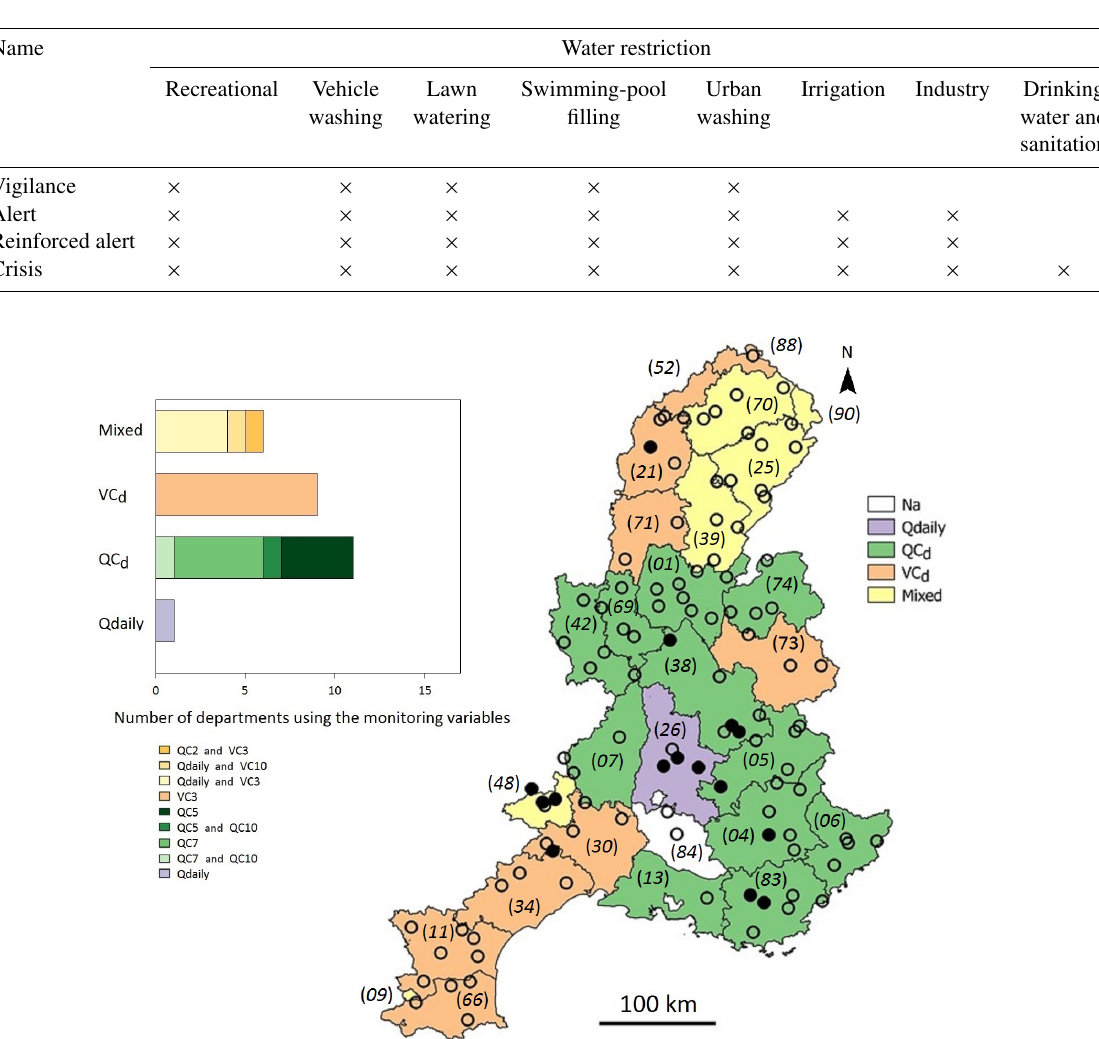
Figure 3. Low-flow monitoring variables used in the current drought management plans. Q daily denotes daily streamflow, Q C d -day maximum discharge, V C refers to the d -day mean discharge, and “Mixed” refers to combinations of the aforementioned variables. d Department codes are given in